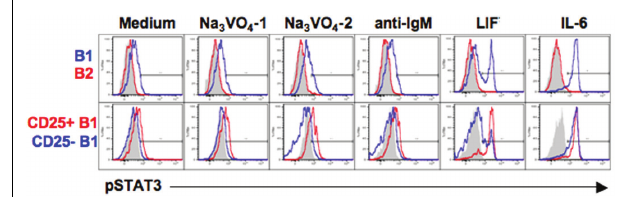
FIGURE 6 | CD25 + B1a cells respond to LIF. Four populations of B cells were sort-purified: peritoneal B1a cells (“B1” in blue in upper panel), splenic follicular B2 cells (“B2” in red in upper panels), CD25 + peritoneal B1a cells (“CD25 + B1” in red in lower panels), and CD25 − peritoneal B1a cells (“CD25 − B1” in blue in lower panels). B cells were cultured in medium alone (“Medium”), with Na 3 VO 4 at 10mM for 1 or 2min, as indicated, with F(ab (cid:2) ) 2 fragments of goat anti-mouse IgM at 15 μ g/ml for 4min (“anti-IgM”), with recombinant LIF at 10ng/ml for 5min, or with recombinant IL-6 at 10ng/ml for 5min. Cells were then harvested, fixed, permeabilized, and examined for intracellular tyrosine phosphorylated STAT3 (“pSTAT3”) by phosphoflow analysis. Isotype control antibody staining is displayed in gray. Representative results from one of three comparable experiments are shown.The displayed results were obtained at the same time as the results shown in Figure 2A